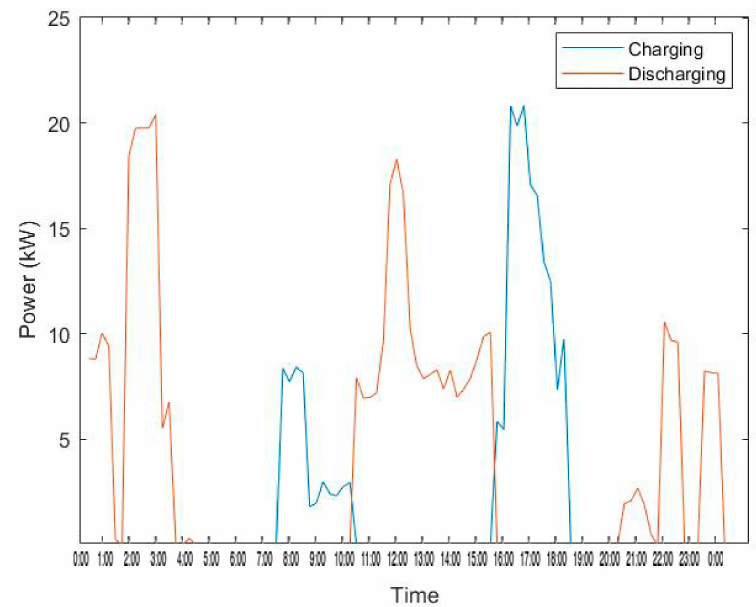
Figure 22. Charging and Discharging of Street Battery in CSPVPD.